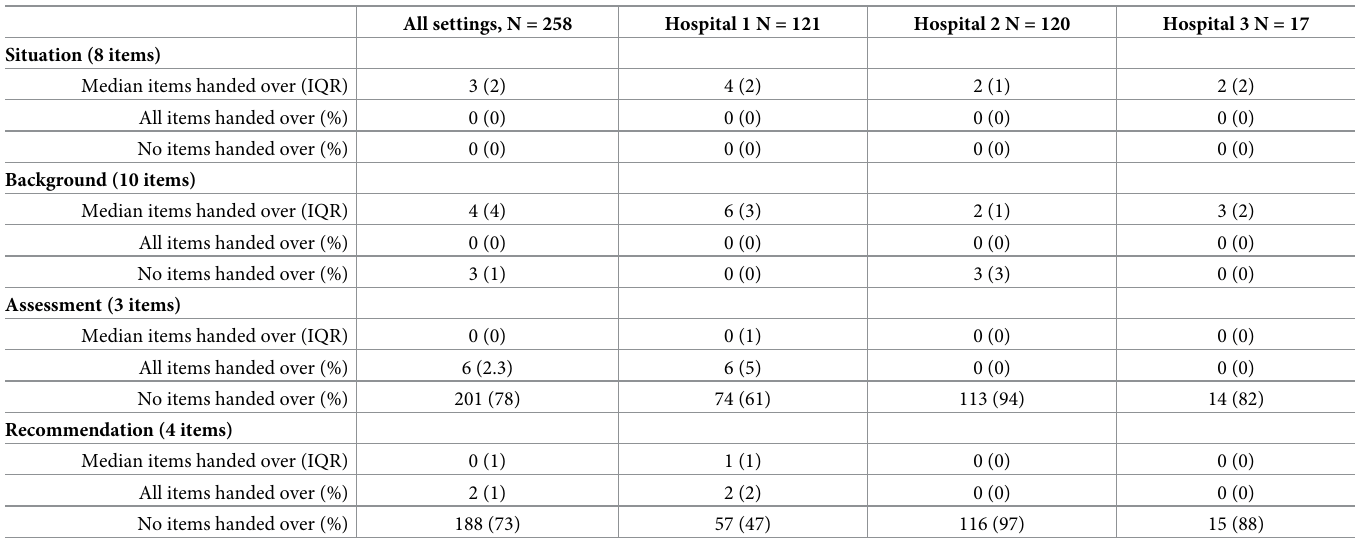
Table 4. Descriptive statistics for each category of SBAR